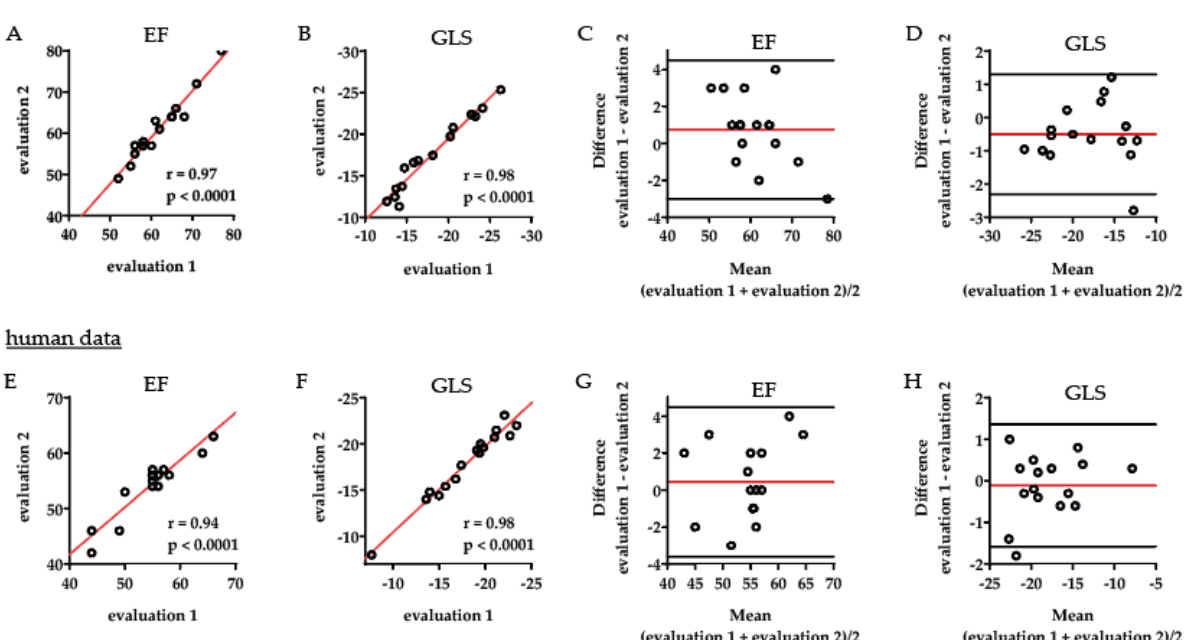
Figure 4. Intraobserver comparison. In analyses of animal data, there was an excellent correlation between the two repeated evaluations of ejection fraction, r = 0.97, p < 0.0001 ( A ), and global longitudinal strain, r = 0.98, p < 0.0001 ( B ) within one observer. The excellent agreement between the two evaluations was substantiated in the corresponding Bland–Altman plots, which showed only a marginal bias, mean difference (95% CI for limits of agreement) 0.75 (4.50 to −3.00) for ejection fraction ( C ) and −0.50 (1.30 to −2.31) for global longitudinal strain ( D ). In human data analyses, there was likewise an excellent intraobserver correlation regarding measurements of ejection fraction, r = 0.94, p < 0.0001 ( E ), and global longitudinal strain, r = 0.98, p < 0.0001 ( F ). Only minor bias was seen in the corresponding Bland–Altman plots: 0.44 (4.48 to −3.61) for repeated evaluation of human ejection fraction ( G ) and −0.11 (1.36 to −1.58) for global longitudinal strain ( H ). EF = ejection fraction, GLS = global longitudinal strain.